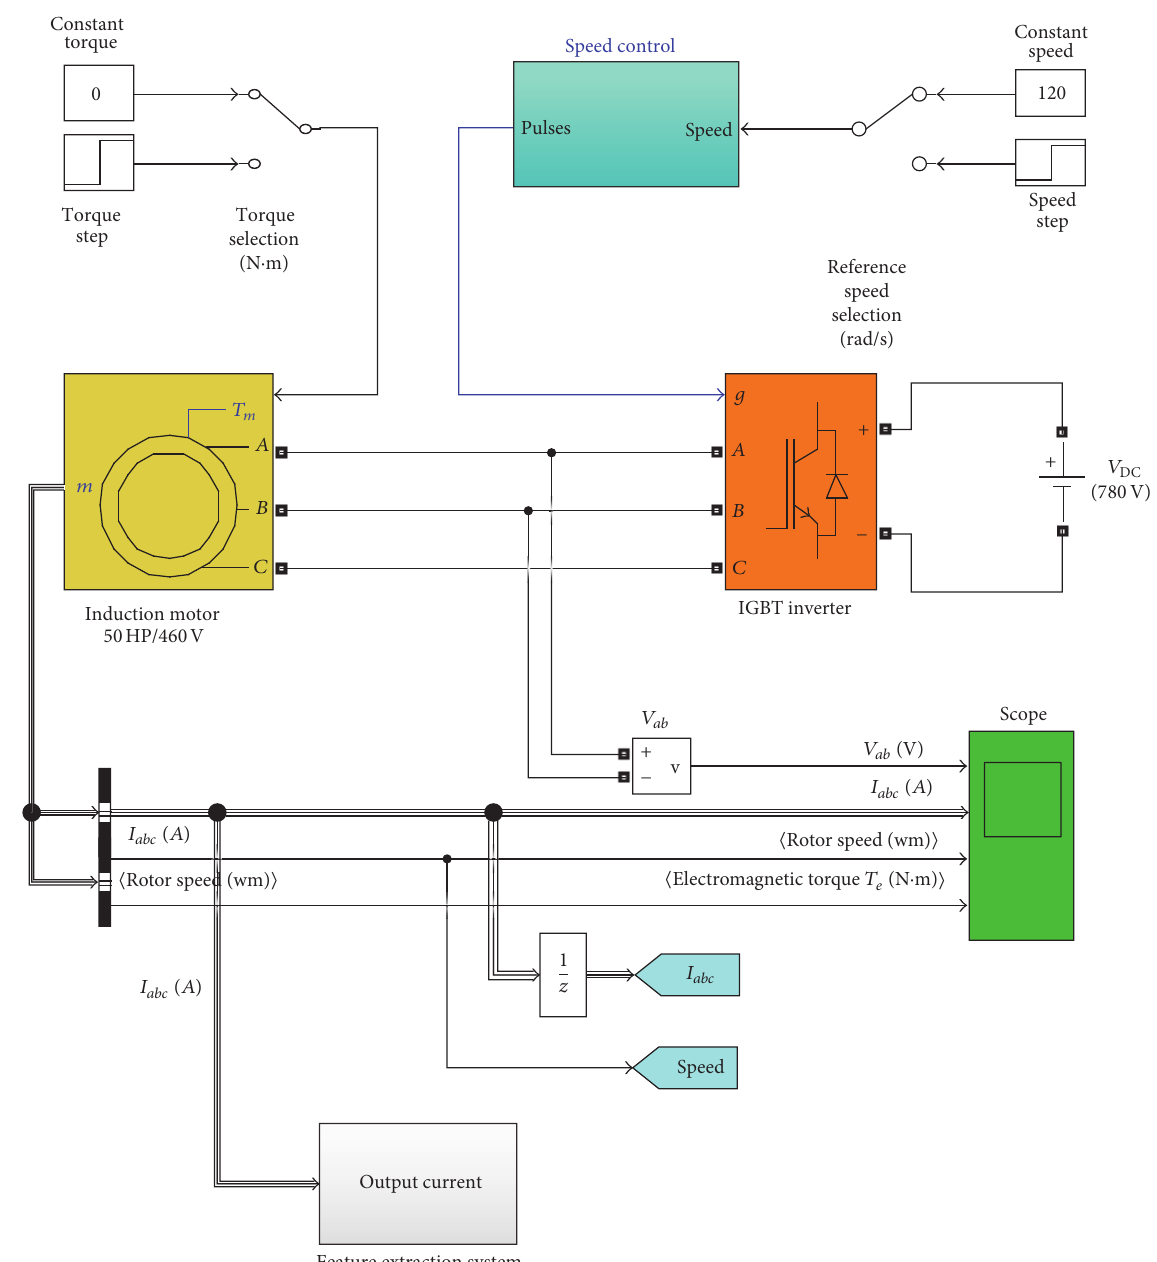
Figure 6: Neural network based fault detection and diagnosis